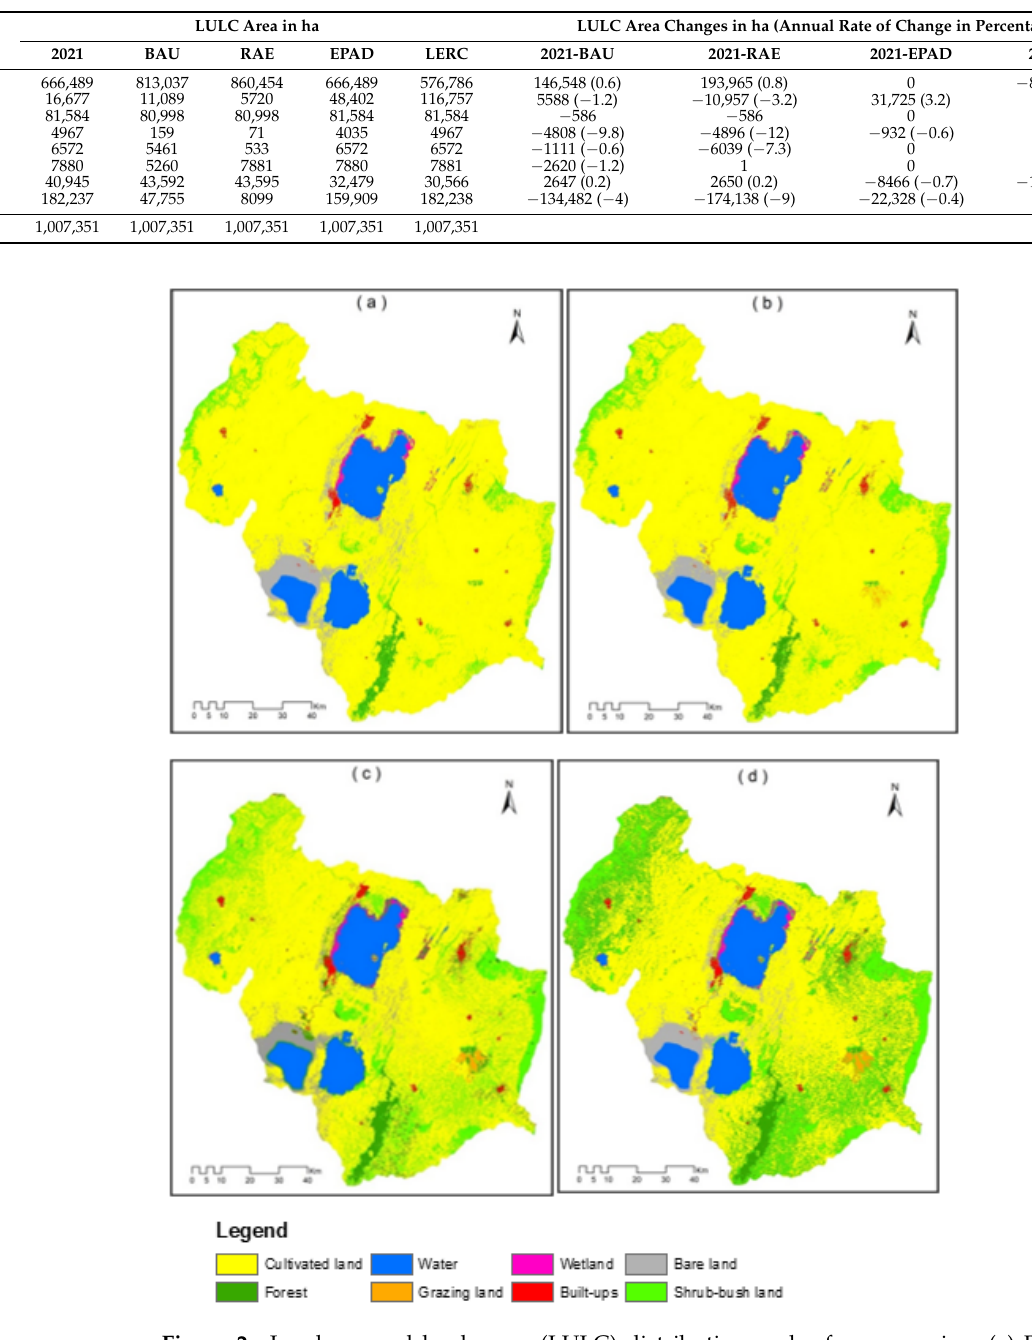
Figure 2. Land use and land cover (LULC) distribution under four scenarios: ( a ) Business-as-Usual (BAU), ( b ) Rapid Agricultural Expansion (RAE), ( c ) Ecosystems Protection and Agricultural Development (EPAD) and ( d ) Landscape Ecosystems Restoration and Conservation (LERC).